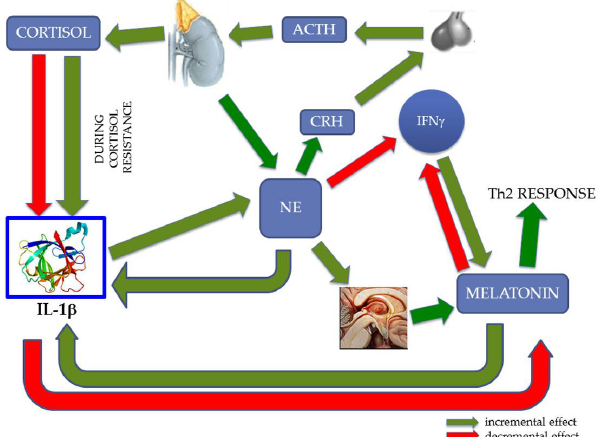
Figure 1. Interplay between central nervous system, endocrine system, and immune system. Under physiological conditions, norepinephrine (NE) activates the HPA axis and determines the production of cortisol that, in turn, downregulates the production of IL-1β. During chronic stress and especially a glucocorticoid-resistant state, the increment of IL-1β transforms this inflammatory signal into a nervous signal: NE. In turn, NE uses the endocrine system (melatonin and cortisol) to rebalance IL-1β, but this control cannot function under cortisol resistance. NE eventually induces a skewing of the immune response, with a reduction in interferon gamma (IFN γ ) and T helper 1 (Th1) activation, and an unbalanced T helper 2 (Th2) response. Other abbreviations: corticotropin releasing hormone (CRH); adrenocorticotropic hormone (ACTH). The protein structure of Inter- leukin 1β (IL-1β) was taken from the RCSB-protein data bank (www.rcsb.org/accessed